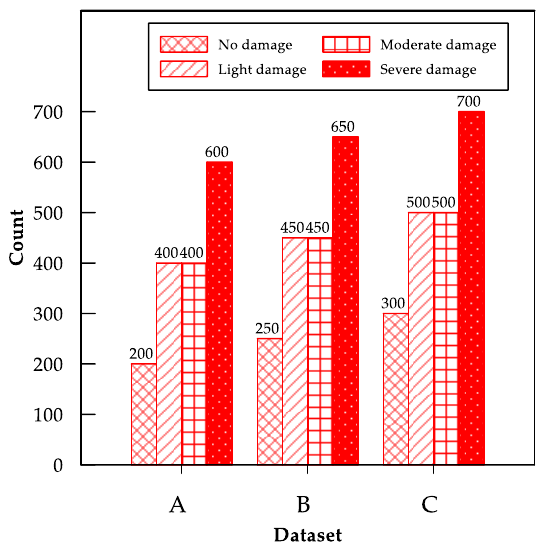
Figure 8. Summary of training and validation datasets for comparative study.